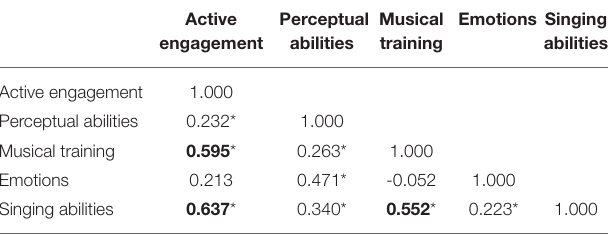
TABLE 7 | Intercorrelations (Spearman’s rank) of subscales of GMSI